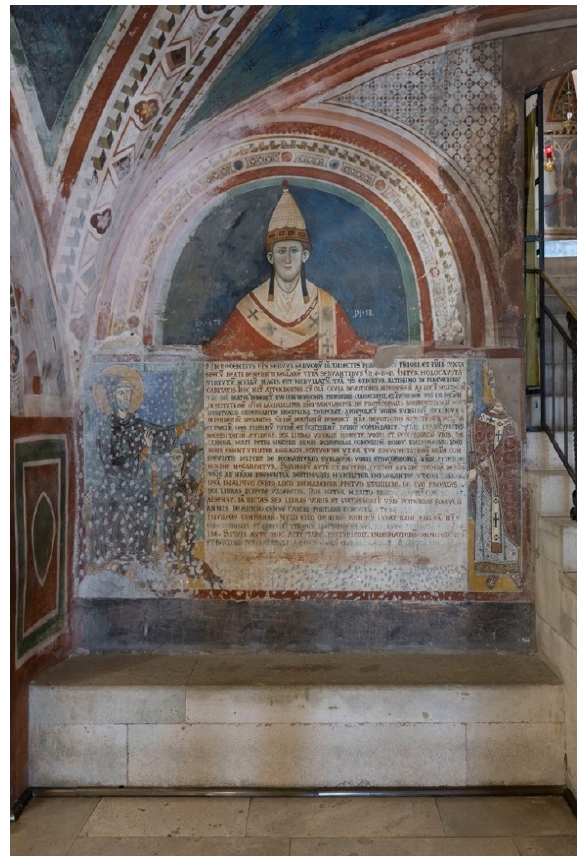
Figure 4. Sacro Speco, Subiaco (Italy), Lower Church. Fresco. Bull of Pope Innocent III. Photo: Davide Giannetti.